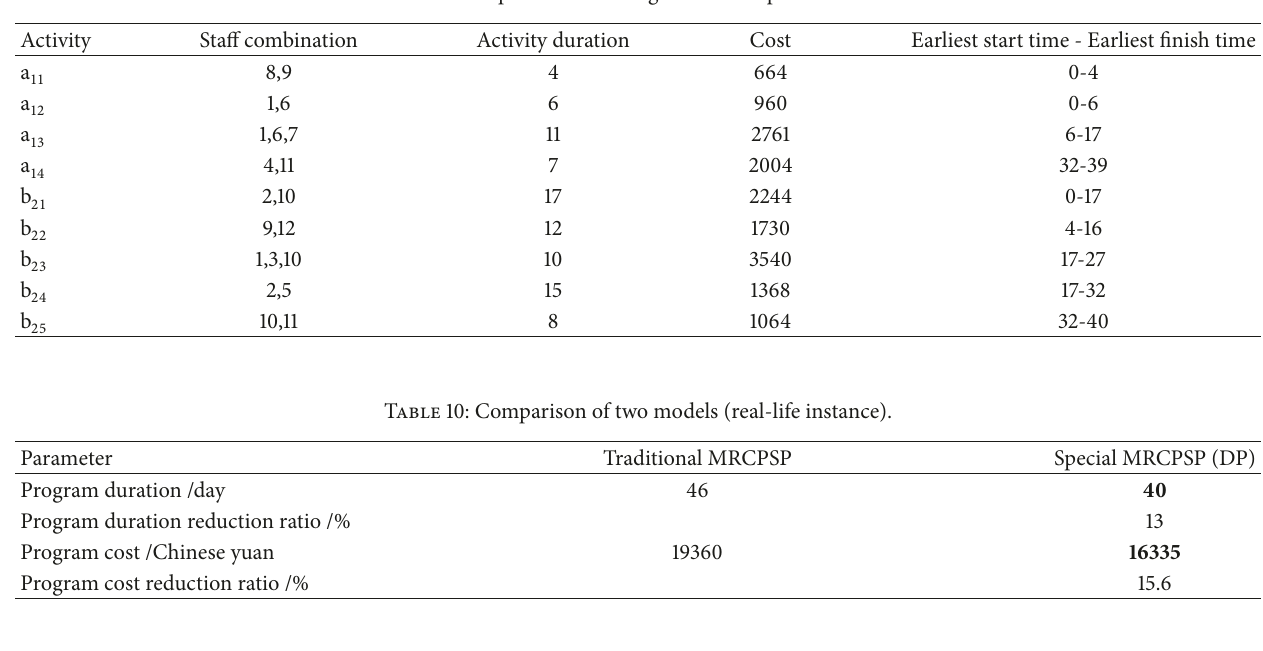
Table 9: The optimal scheduling scheme of special MRCPSP.